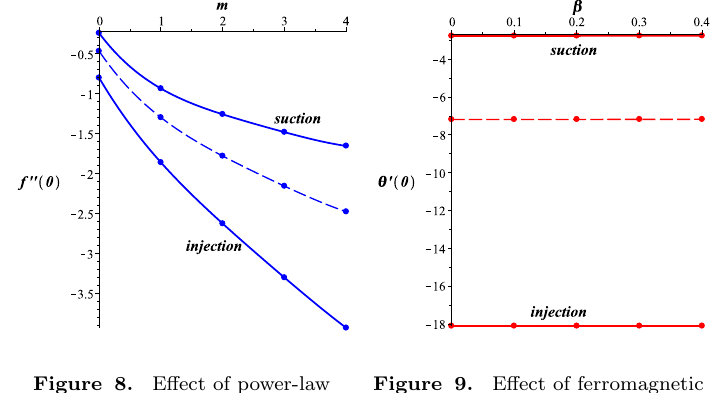
Figure 8. Effect of power-law exponent m on the skin friction coefficient.